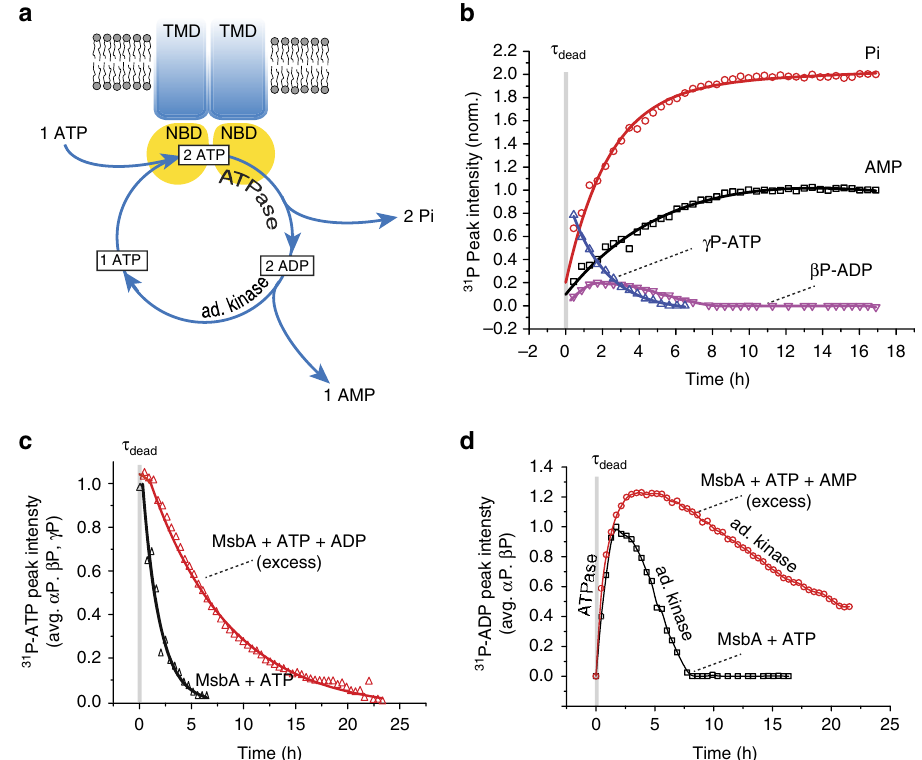
Figure 3 | Proposed model for a coupled ATPase-AK reaction. ( a ) Hydrolysis turns ATP into ADP and Pi, followed by conversion of both ADP into AMP and ATP. ( b ) This coupled catalytic activity results in 31 P progress curves for each nucleotide species obtained by deconvoluting the data set in Fig. 1b. The observed integral peak intensities correspond to a stoichiometry of ATP at the beginning of the reaction AMP and Pi at the end of 1:1:2. ( c ) The progress curve for the consumption of ATP decays slower if ADP is added in excess in addition to ATP. ( d ) The ATPase activity of MsbA results in an initial positive slope of the ADP progress curve, whereas its kinase activity causes a decrease. The addition of excess AMP in addition to ATP has a small effect on the initial increase but significantly slows down ADP consumption. Full data sets for ( c , d ) are provided in Supplementary Fig.